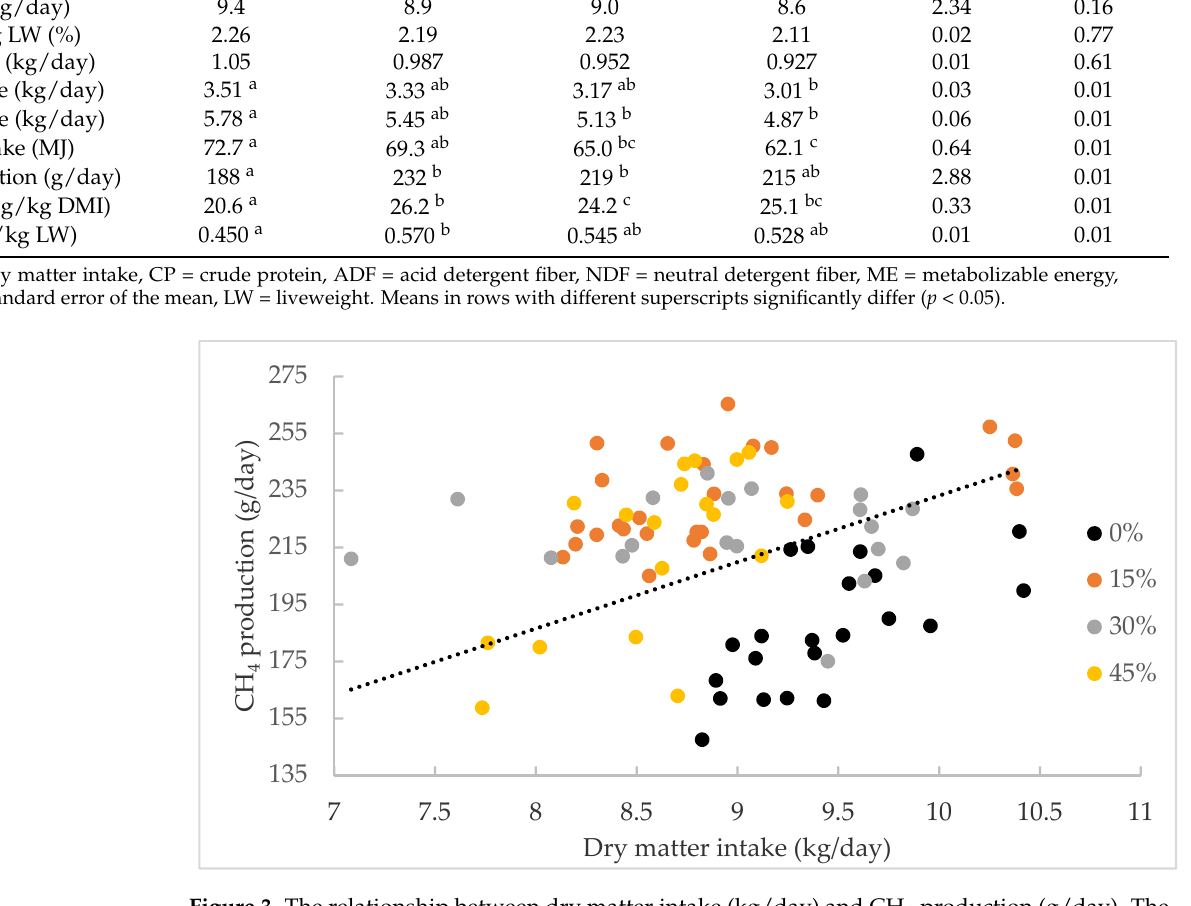
Figure 3. The relationship between dry matter intake (kg/day) and CH 4 production (g/day). The relationship can be described as CH 4 production (g/day) = 23.32X, where X = dry matter intake (kg/day) R 2 = 0.68, p = 0.028.